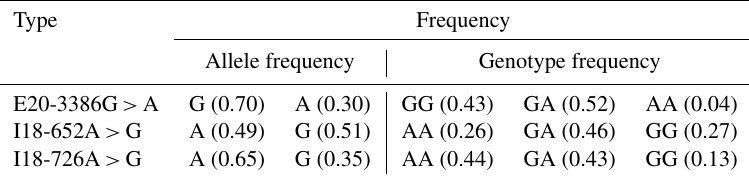
Figure 2. Analysis and sequencing of SNPs in the GPAM gene. Panel (a) shows the determination and sequence analysis of SNPs in the GPAM gene’s functional regions; panel (b) shows that there was a G to A substitution at position 3386bp of the 20th exon in the GPAM gene that replaced arginine with histidine, and there was no alteration in amino acids at locations I18-726A > G and I18-652A > G. Table 3. SNPs of the GPAM gene in China Holstein dairy cattle.